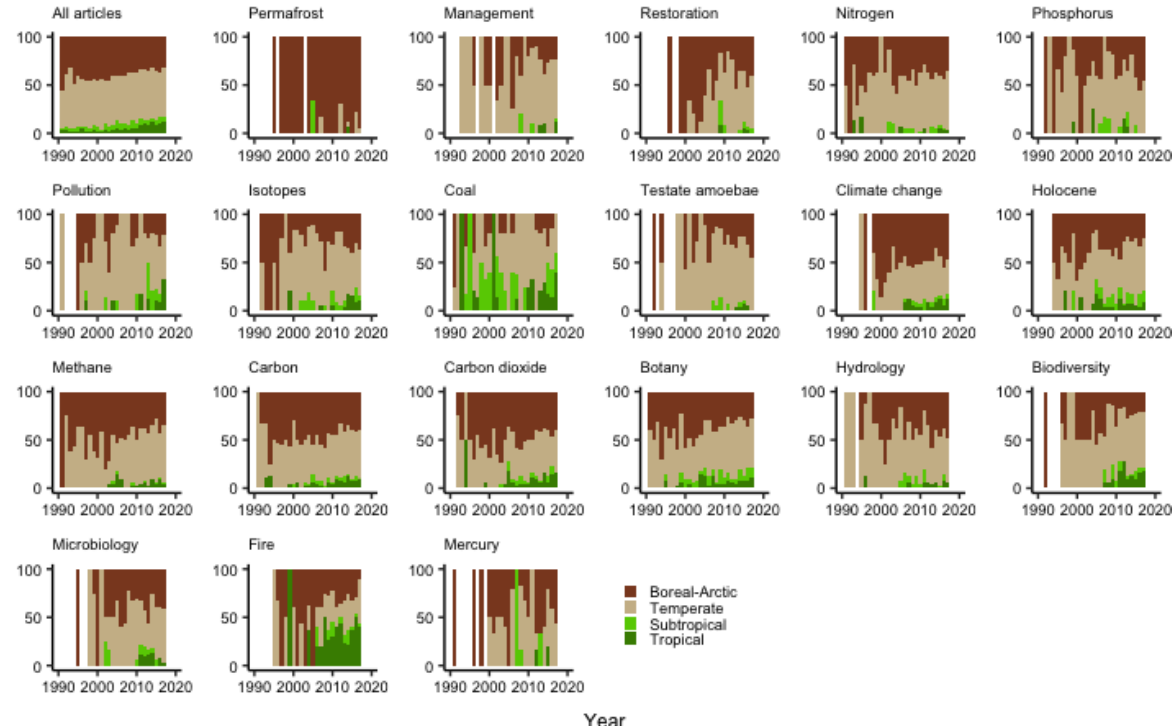
Figure 9. Temporal dynamics of research topics, quantified by the number of articles in which keywords appeared, according to four geographical zones. Topic order follows the order in the dendrogram of Figure